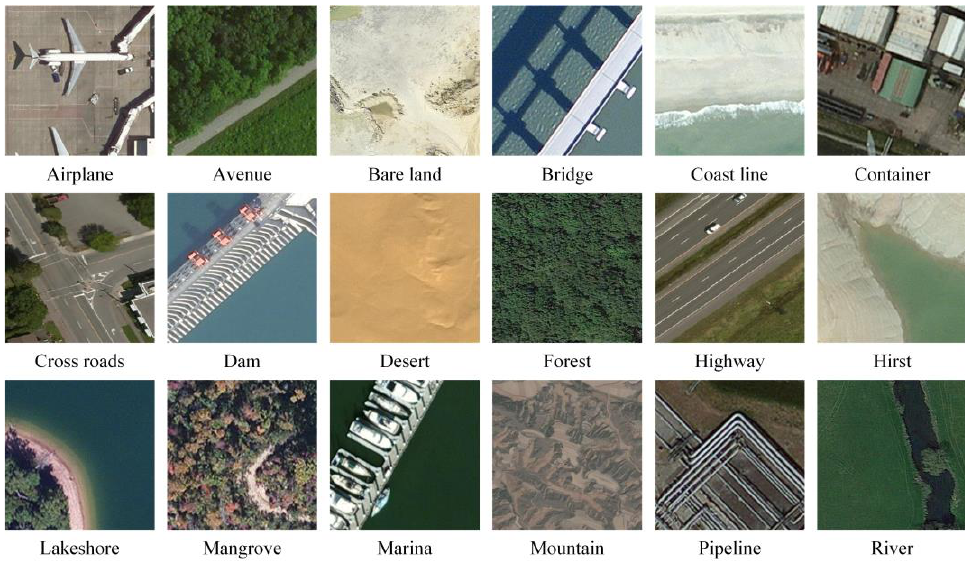
Figure 4. Several scene image samples on RSI